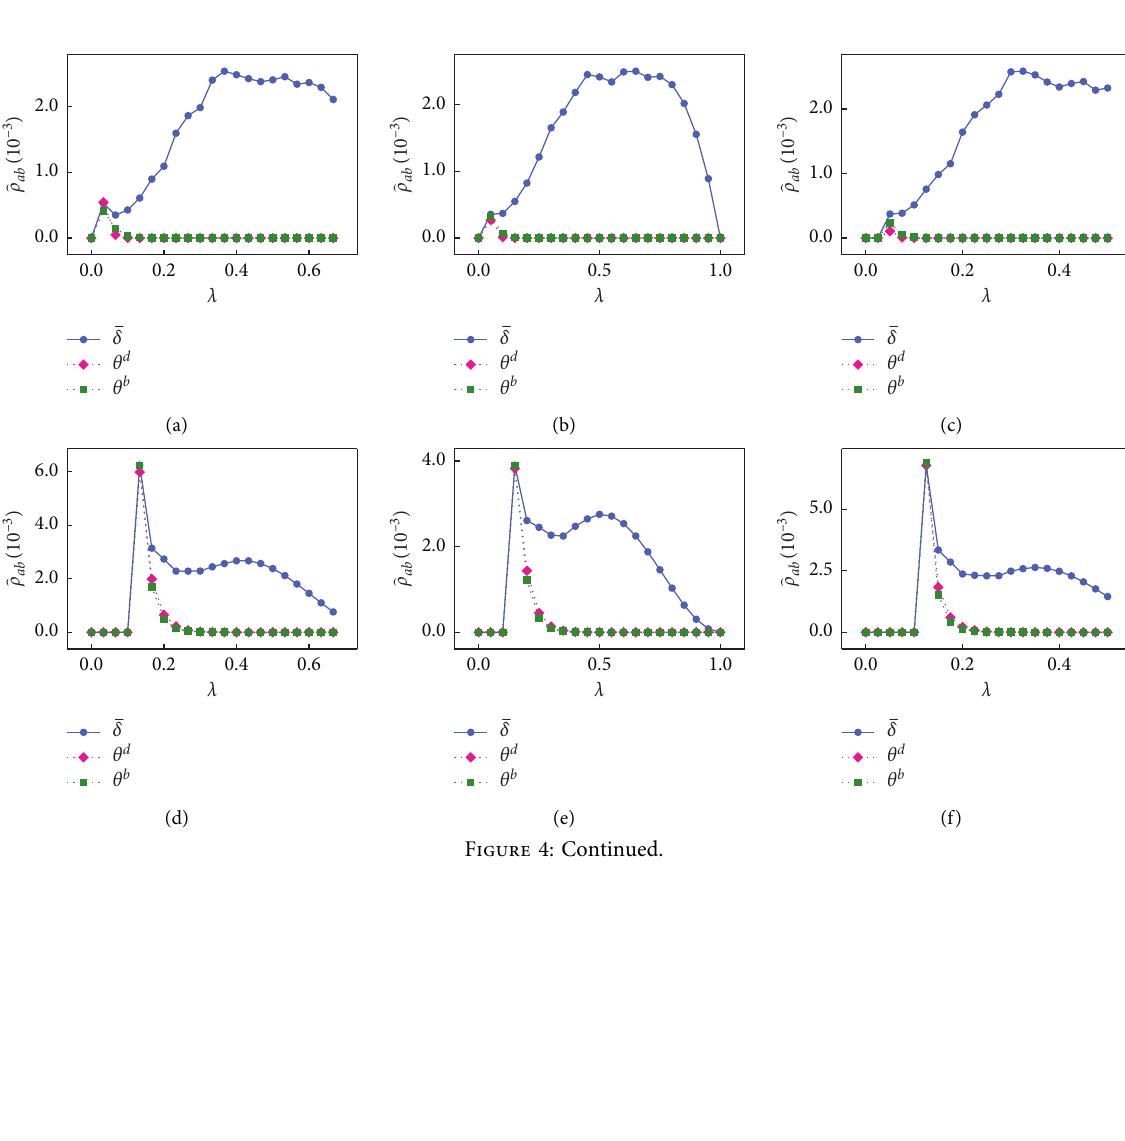
Figure 3: Incremental cooperative spreading prevalence 􏽢 ρ ab after adding the optimal latent edge to the SF network. The incremental cooperative spreading prevalence 􏽢 ρ ab after adding the optimal latent edge scored by δ (blue circles), product θ d (pink diamonds), or θ b (green squares) versus λ when (a) β � 1, (b) β � 1 . 5, and (c) β �